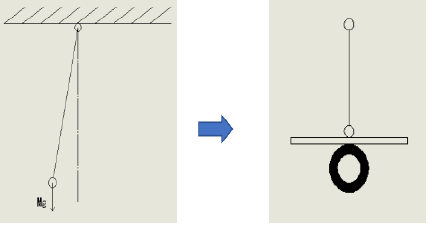
Figure 4. The car body is simplified to an inverted pendulum